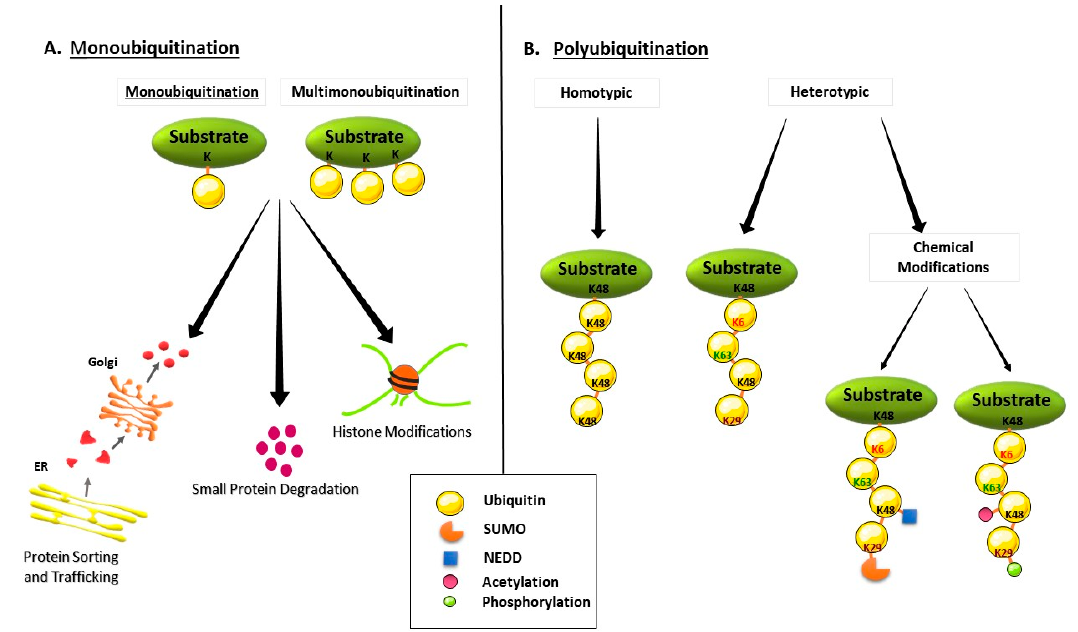
Figure 1. Types of Ubiquitination. ( A ) Monoubiquitination, ( B )